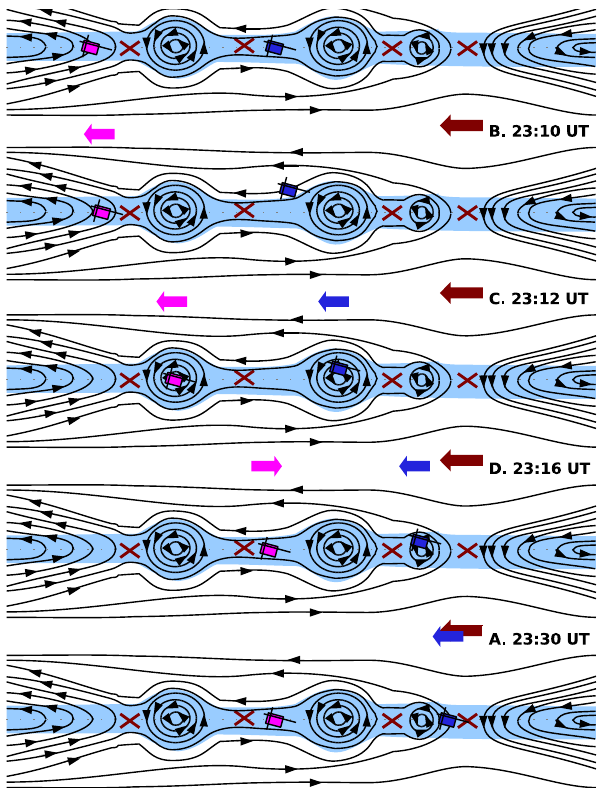
Fig. 8. An illustration of a possible sequence of events explaining the data. The dark blue spacecraft represents Cluster, and the ma- genta TC-1. Flows detected by each spacecraft are depicted as ar- rows of the relevant colour, whereas the red arrows represent the re- connection flow driving the system. Possible reconnection sites are marked as red Xs. A notional current sheet is depicted by the light blue shading. Panels (A–E) show the tail configuration at 23:07 UT, 23:10 UT, 23:12 UT, 23:16 UT and 23:30 UT, respectively. This figure represents the tail configuration with the minimum number of reconnection sites possible to explain the presence of three flux